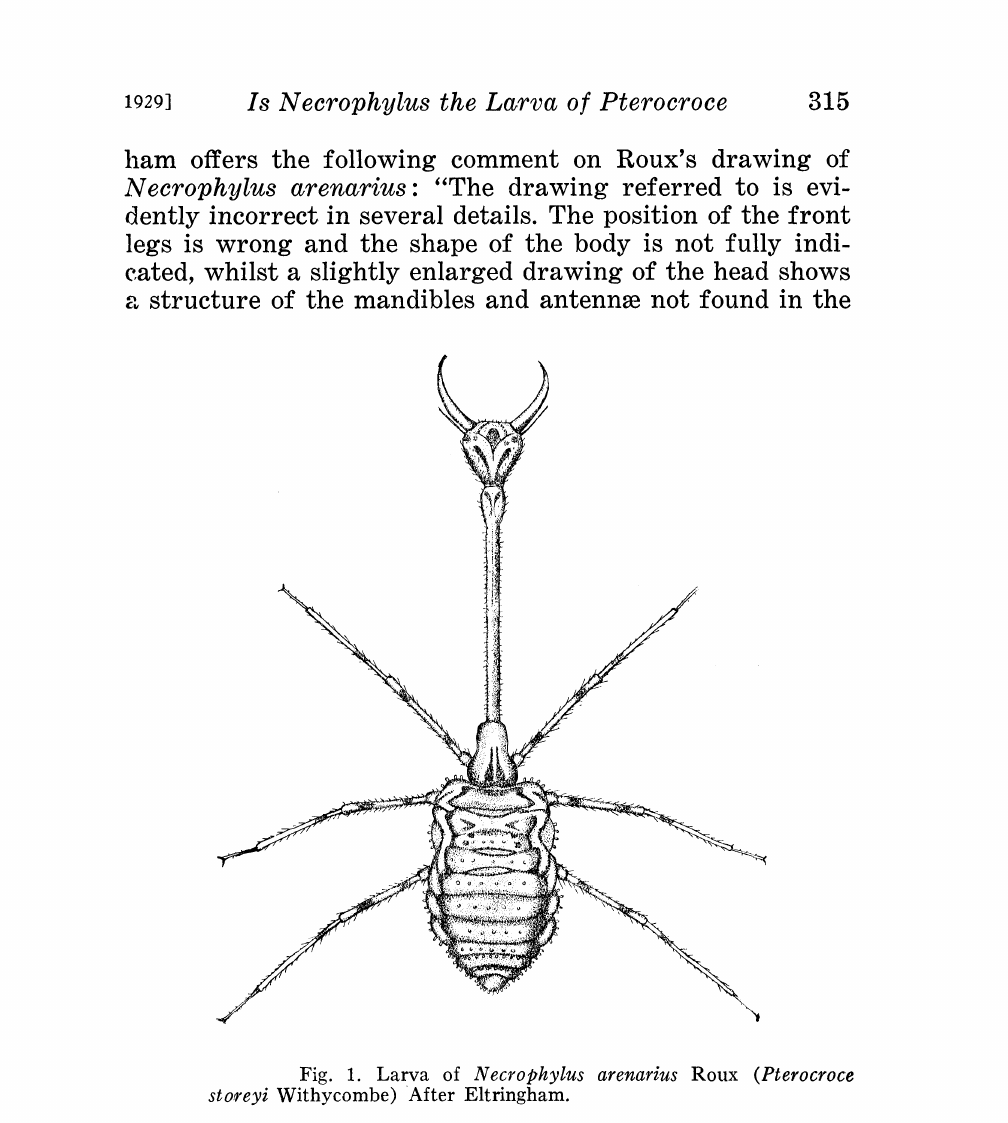
Fig. 1. Larva of Necrophylus arenarius Roux (Pterocroce storeyi Withycombe)After